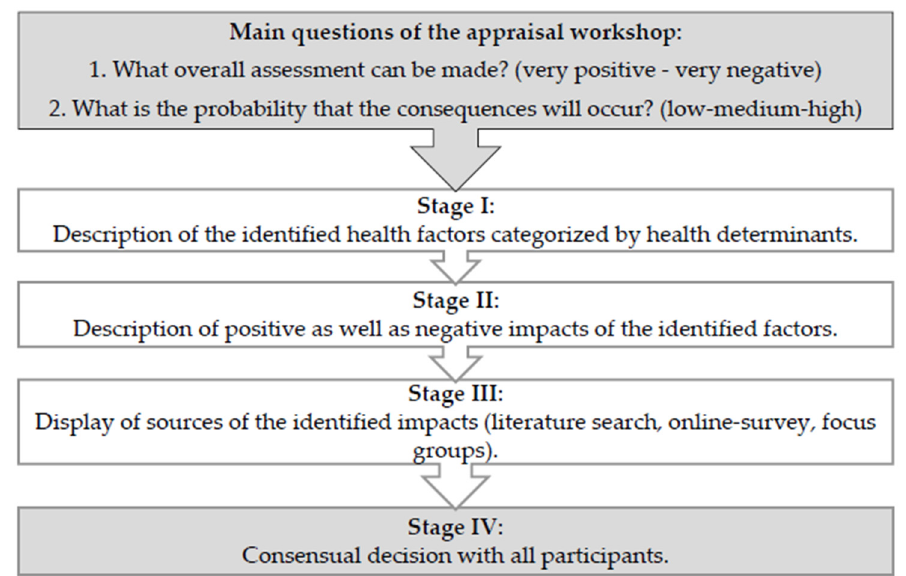
Figure 1. Graphical representation of the assessment process.